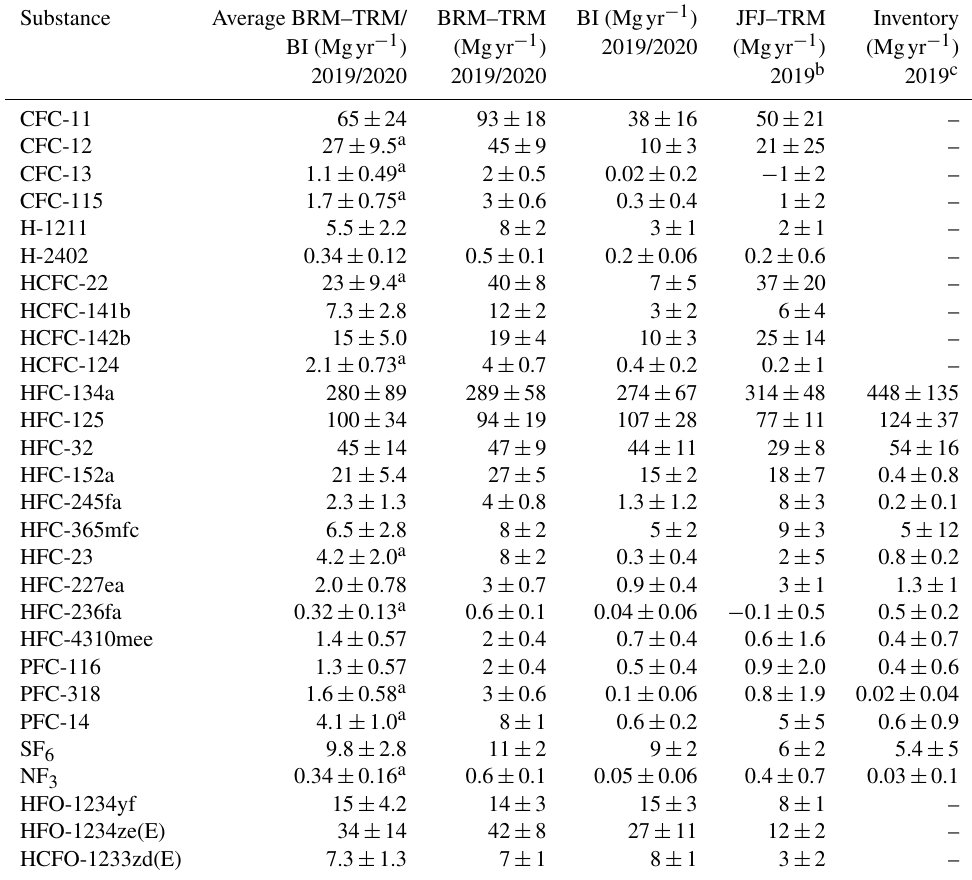
Table 2. Calculated Swiss emissions for 2019/2020, including the Beromünster (BRM) measurements, with the tracer ratio method (TRM) and Bayesian inverse (BI) modelling. The results are compared to the Jungfraujoch (JFJ)-based emission values for 2019 and the Swiss inventory for 2019. The average BRM–TRM and BI values are rounded to two significant figures. Uncertainties are given at 2 σ